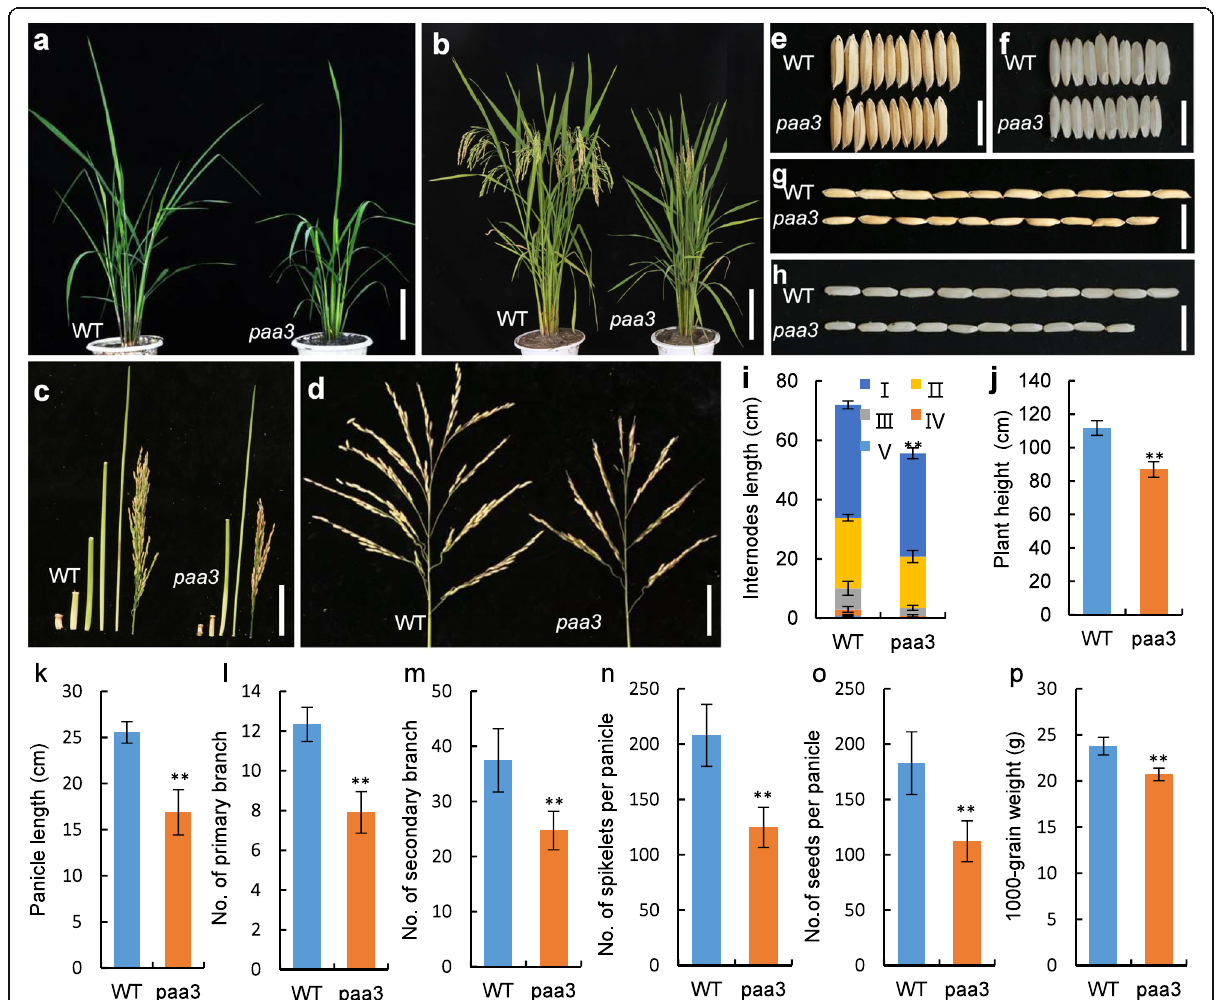
Fig. 1 Phenotypic characterization of the rice ( panicle apical abortion3 ) paa3 mutant. a : Morphology of wild-type (WT) and paa3 plant seedling stage. b : Morphology of WT and paa3 plant at maturity. c : Internodes and panicle of WT and paa3 . d : Panicle branch architectures of WT and paa3 . e : Comparison of grain morphology width between WT and paa3 . f Comparison of brown rice morphology width between WT and paa3 . g : Comparison of grain morphology length between WT and paa3 . h : Comparison of brown rice morphology length between WT and paa3 . i : Panicle length. j : Plant height. k : Panicle height. l : Number of primary branch. m : Number of secondary branch. n : Total number of spikelets. o : Number of seeds per panicle. p : 1000 grain weight. Bars: ( a , b )10 cm; ( c , d ) 5 cm; ( e – h ) 1 cm. ** p < 0.01 (Student ’ s at the top of the paa3 panicles from ~ 9 to ~ 17 cm (Fig. 2b1 – b10). At the ~ 9 cm panicles, there were no obvious differences between the WT and the paa3 spikelets (Fig. 2b1, b2). However, some of the spikelets at the top of the ~ 11 and ~ 13 cm panicles displayed white hulls and smaller size in paa3 mutants, whereas the WT had green hulls and were larger in size (Fig. 2b3 – b6). In about ~ 15 cm paa3 panicles, the spikelet organs at the top of the panicles began to browning (Fig. 2b7, b8), and in the ~ 17 cm paa3 panicles, the spikelets were com- pletely dry (Fig. 2b9, b10). According to these results, we speculated that the spikelets located at the top of the paa3 panicles stopped growing at ~ 9 to 11 cm, after which cell death occurred gradually. We also observed